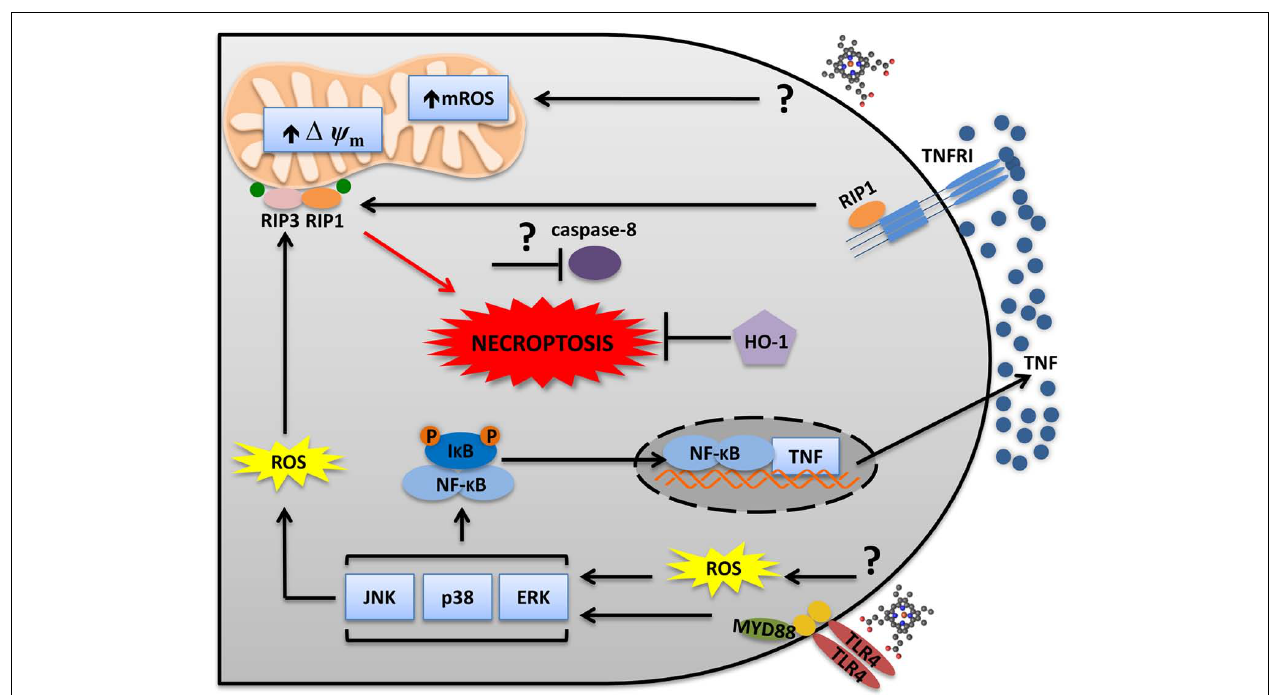
FIGURE 2 | Heme induces RIP1/RIP3-dependent programed cell death. Heme triggers two distinct but integrated pathways to promote necroptosis. Heme induces ROS generation independently ofTLR4. ROS sensitizes macrophages toTNFR-induced cell death. Heme-inducedTLR4 activation leads to MAPKs activation andTNF production.While JNK increases ROS generation,TNF induces RIP1–RIP3 necrosome which triggers necroptosis.